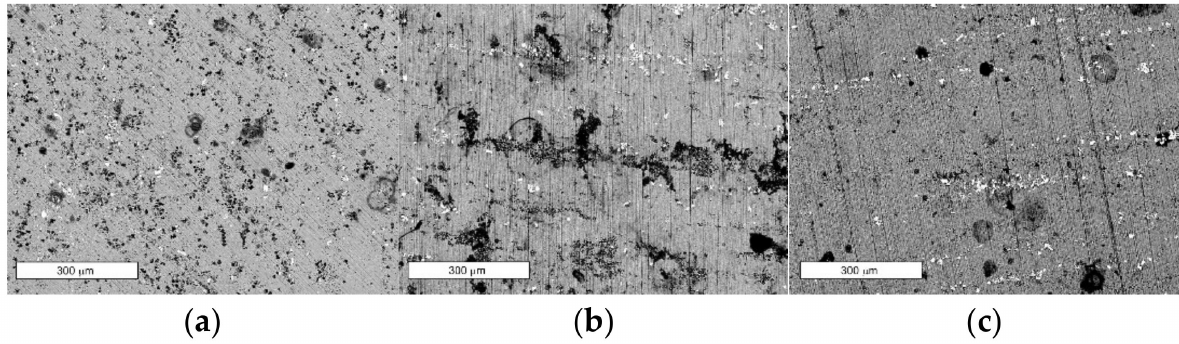
Figure 17. An exemplary general view of the surface of samples after electrochemical tests in the states: T6 ( a ), DA ( b ), and RRA ( c ); SEM.